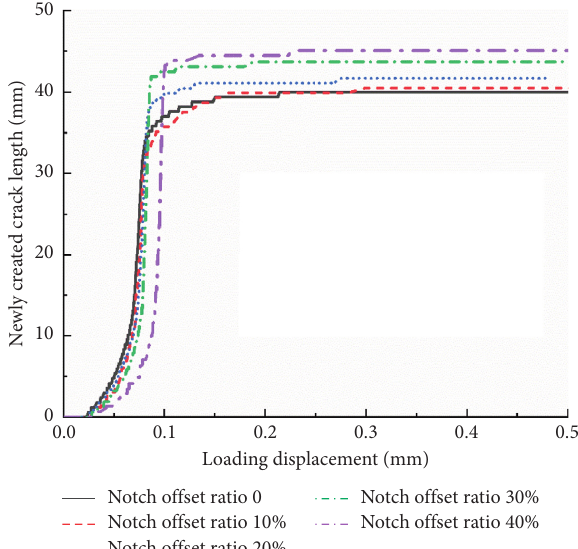
Figure 9: Crack patterns for the rock beams with different notch offset